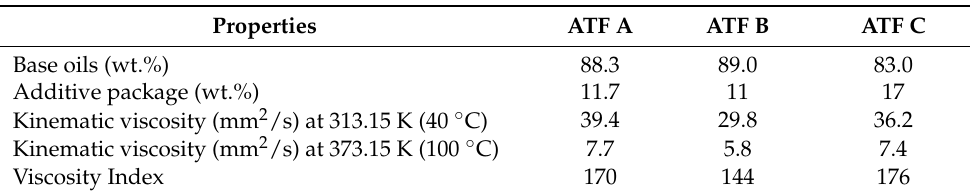
Table 1. Composition and viscosity properties of the ATFs.